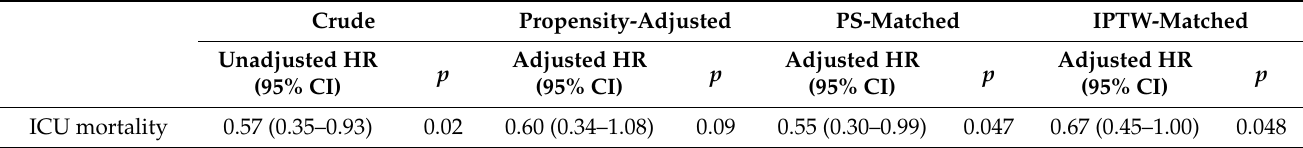
Table 4. Association between the vitamin C protocol and ICU mortality.